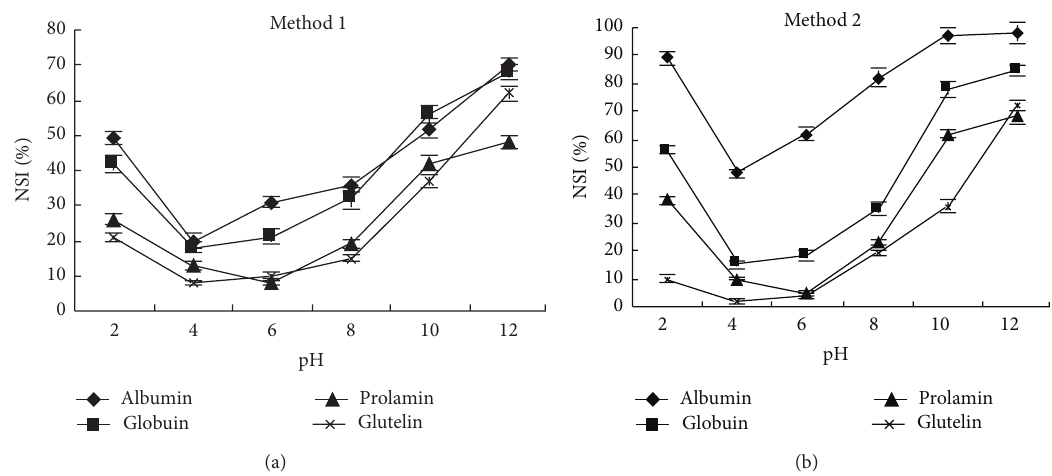
Figure 2: Protein solubility at different pH levels of FRBPs prepared by the two extraction methods.